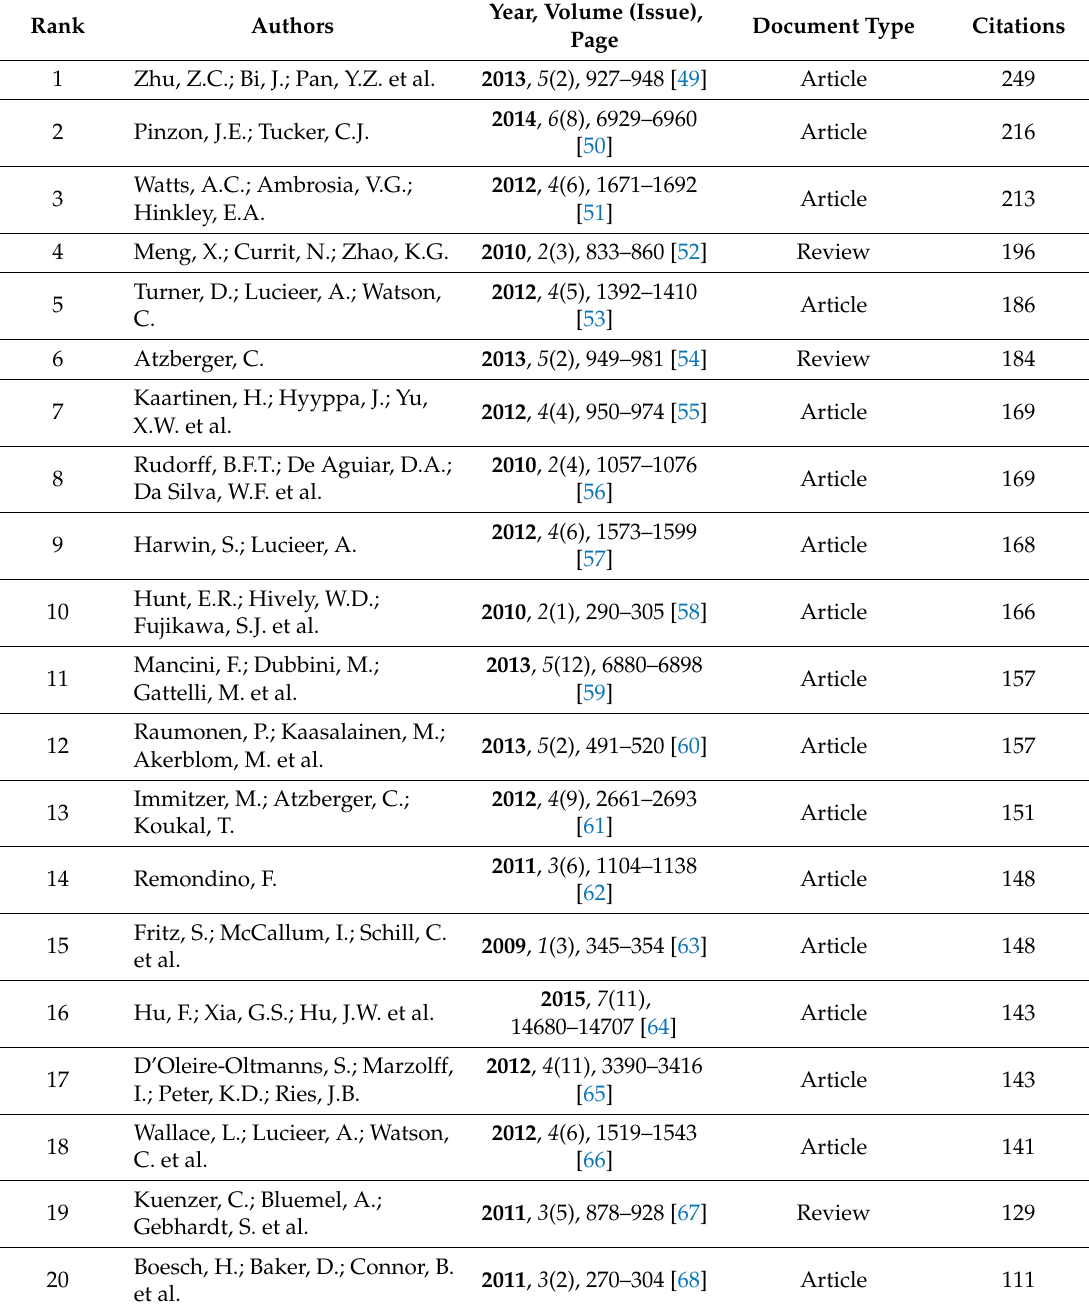
Table 3. H-classic publications published by RS OAJ (top